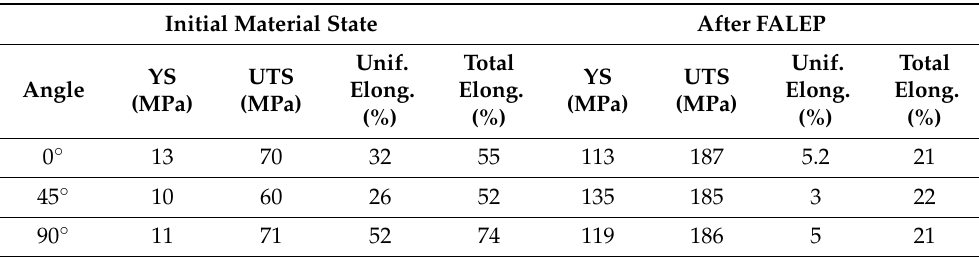
Figure 7. ( a ) Engineering tensile stress-strain curves of the initial sample and the FALEP-processed 1 mm thick Al-1050 fin obtained at 0°, 45°, and 90° with respect to the flow direction (FD), at room temperature. ( b ) Enlarged part of the stress-strain curve. The broken line corresponds to 0.2% plastic strain. ( c ) The geometry of the tensile specimens (mm). Table 1. Tensile test results on Al-1050 in initial state and after processing by FALEP. (YS: von Mises equivalent yield strength; UTS: ultimate strength.)